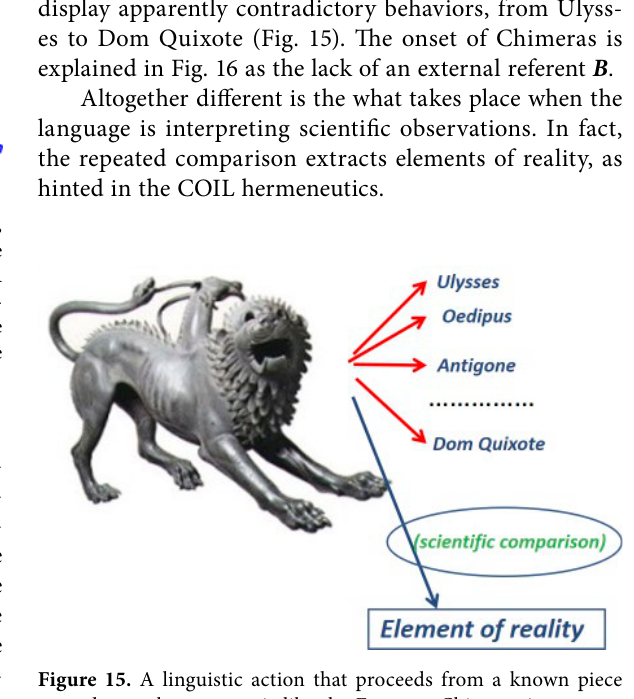
Figure 15. A linguistic action that proceeds from a known piece toward an unknown one is like the Etruscan Chimera: it can gen- erate mutually conflicting behaviors , as it occurs in most charac- ters ,from Ulysses to Dom Quixote.When instead the linguistic comparison regards two observed items (as it occurs in reading the verses of a Poem, but also in scientific observations), then we really increase our personal knowledge with an element of reality.